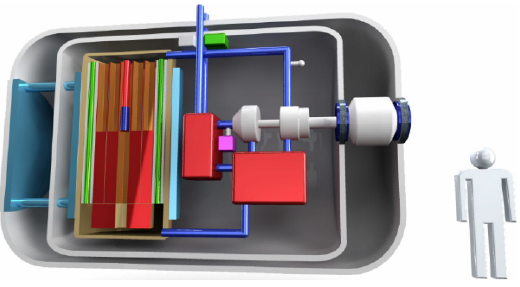
Figure 1. Schematic layout of Korea Advanced Institute of Science and Technology (KAIST) micro modular reactor (MMR).